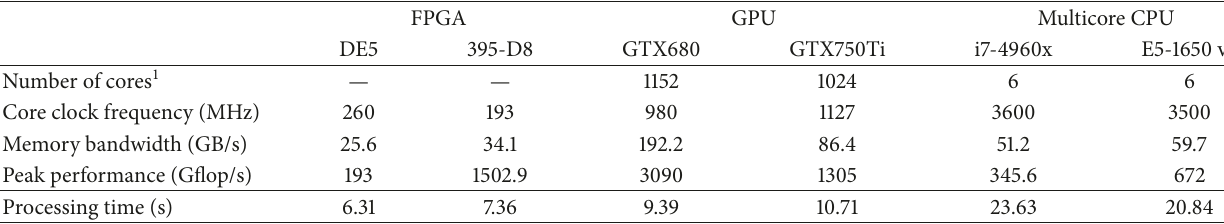
Table 2: Comparison with GPUs and CPUs using single-precision floating-point